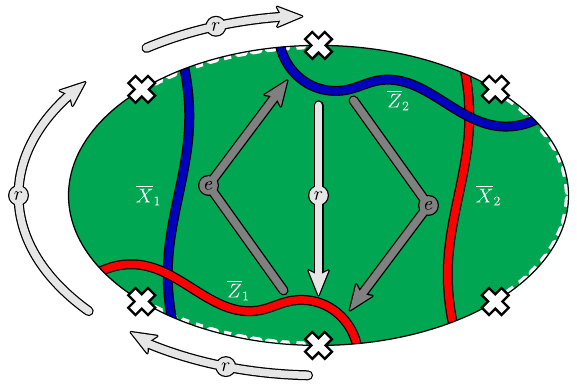
FIG. 10. A surface code that encodes two logical qubits. ¯ X ¯ Z ¯ X ¯ Z Logical operators 1 , 1 , 2 , and 2 , which act on qubit 1 and qubit 2, are shown. Exchanging the two central qubits along the trajectories shown by the dark grey arrows, which are marked by e , entangle the two logical qubits. This exchange can be performed without decreasing the code distance beyond a small constant amount on an L × 2 L lattice with the square geometry we show in Fig.